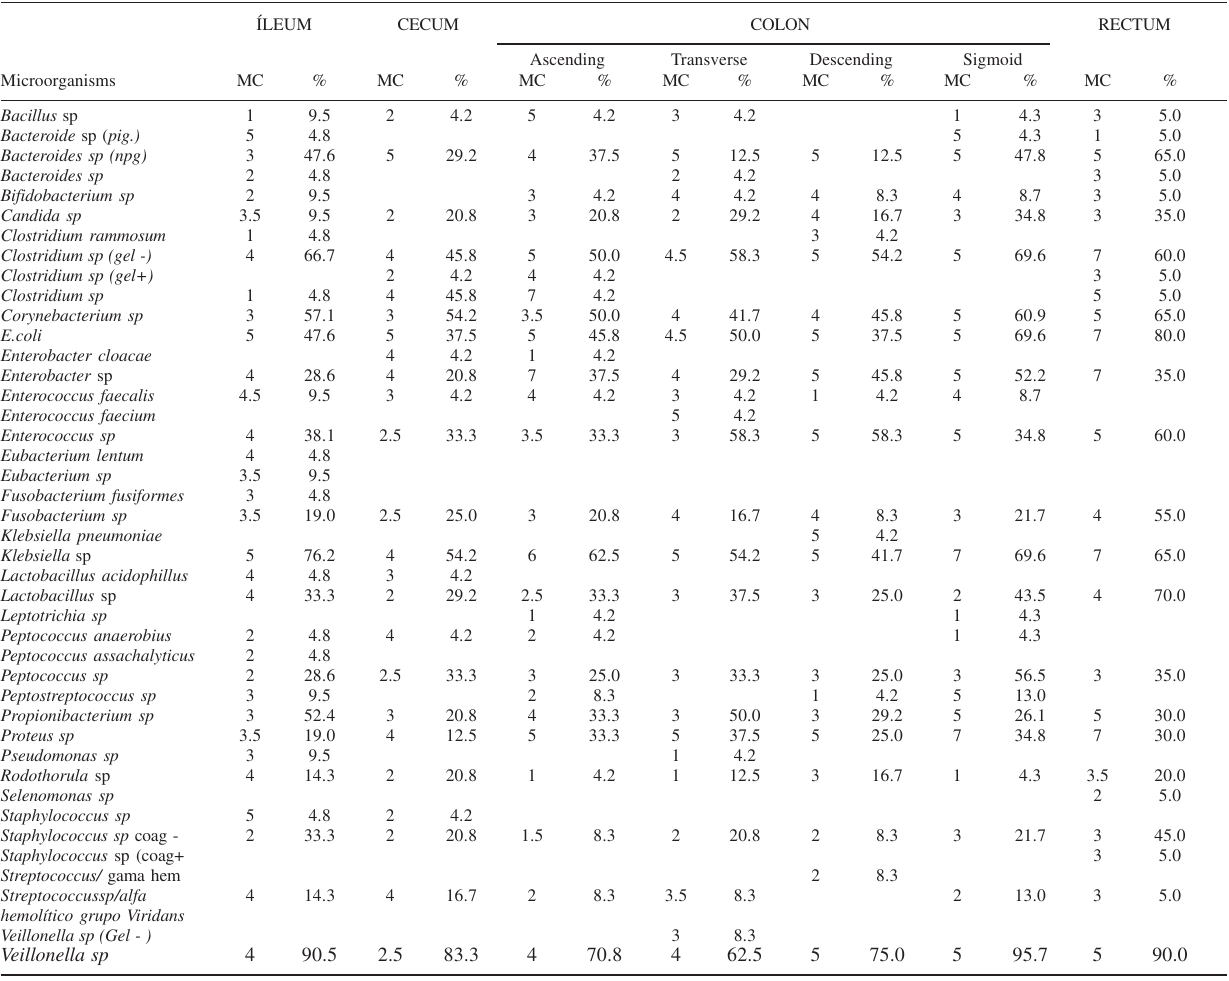
Table 4 - Mean Concentration and Prevalence (%) of Microorganisms in each Site of the LDT